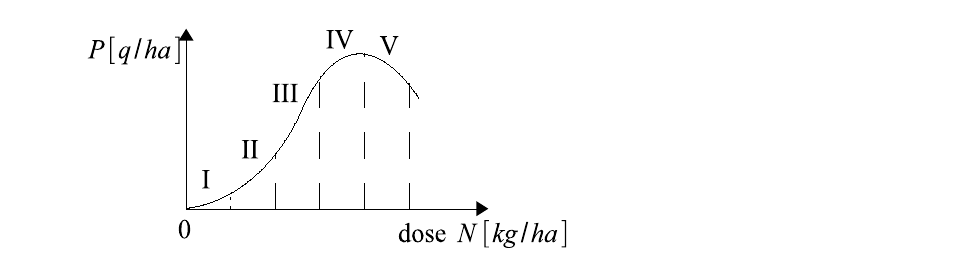
Figure 31. The most common qualitative response curve for nitrogen ( N )